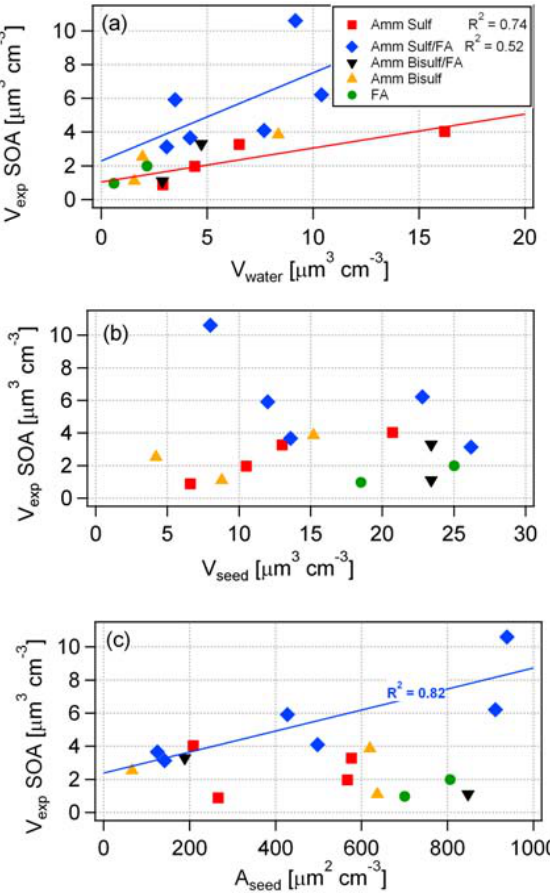
Fig. 5. Observed SOA volumes in the experiments by Volkamer et al. (2009) as a function of (a) water mass associated with seed aerosol; (b) total seed mass (water + seed); (c) total seed surface. The lines depict linear correlations for ammonium sulfate and am- monium sulfate/fulvic acid